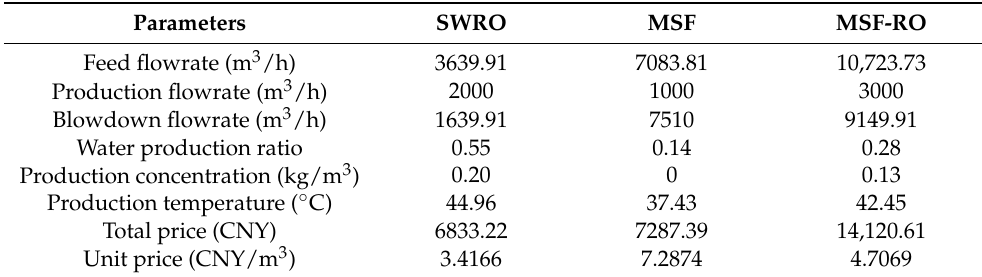
Table 19. Overall water production in option 5.